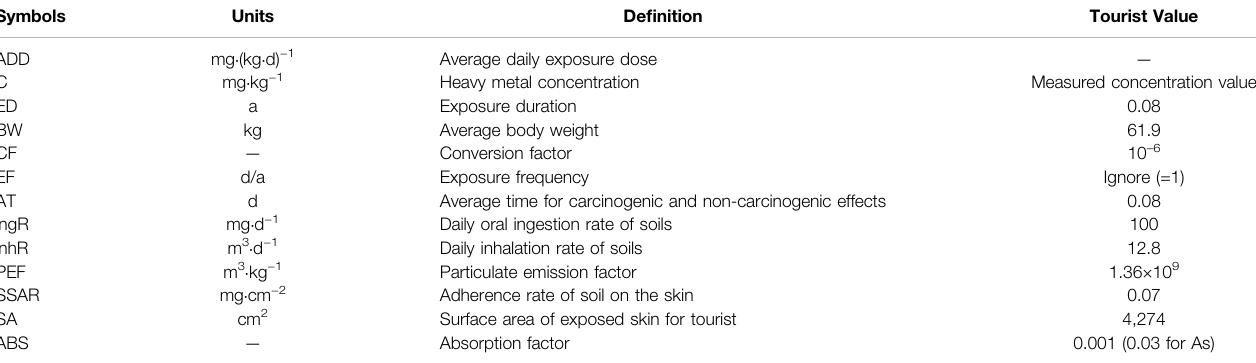
TABLE 2 | De fi nition and the reference values of parameters for health risk assessment of heavy metals in soils (EPA 2011). Symbols